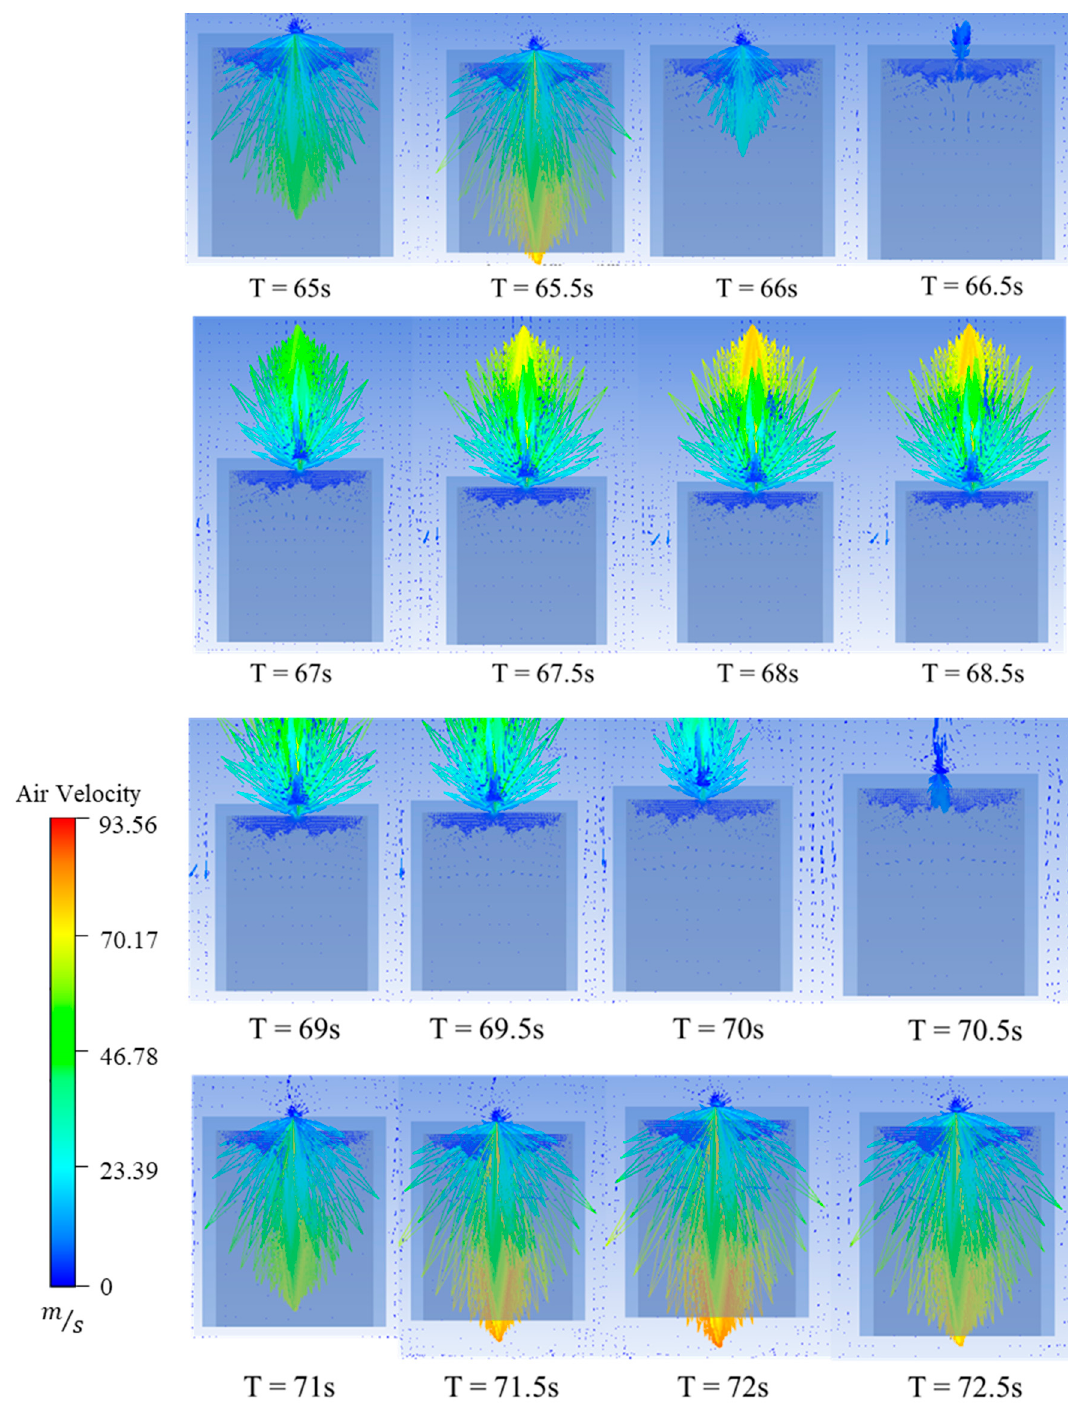
Figure 8. Variations of air-flow in the air-chamber of the OWC corresponding to time.